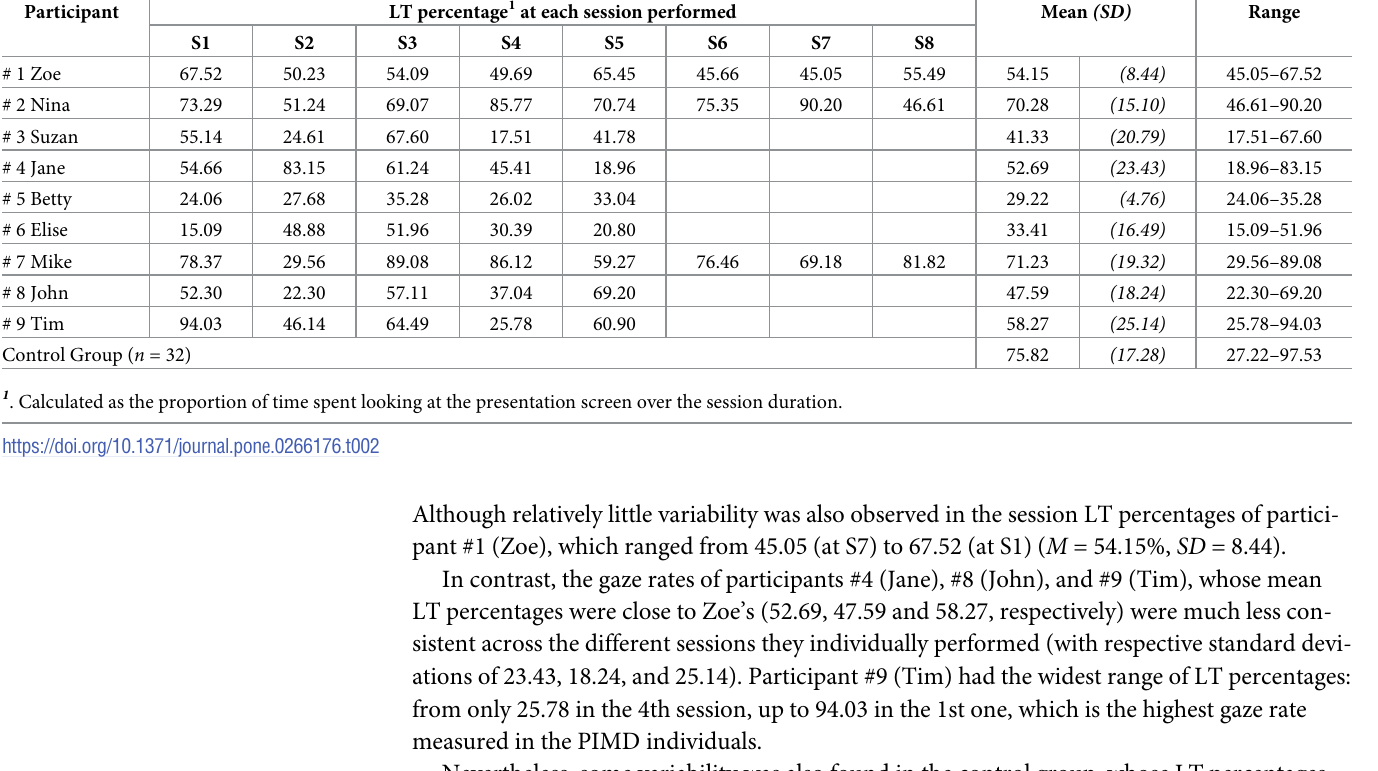
Table 2. Preliminary analyses: Descriptive statistics of looking times (LT) of the nine PIMD participants and the control group (session percentages, means, stan- dard deviations, and ranges). Participant LT percentage 1 at each session